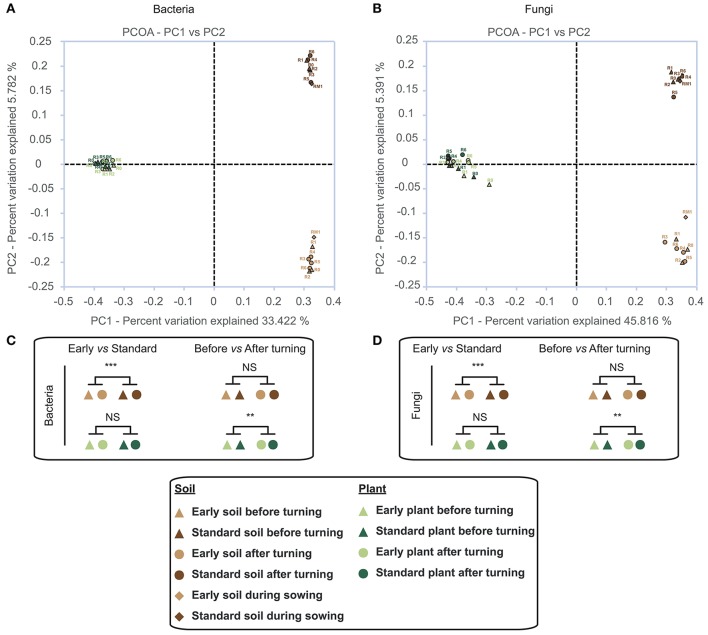
Principal coordinate analysis (PCoA) of bacterial (A) and fungal (B) community membership based on Jaccard distances. Different colors indicate the source samples (light brown, soil early harvest; dark brown, soil standard harvest; light green, plant early harvest; dark green, plant standard harvest). Triangles, samples before swath turning; circles, samples after swath turning; lozenge, soil sample during sowing. (C,D) statistically significant clustering based on AMOVA.